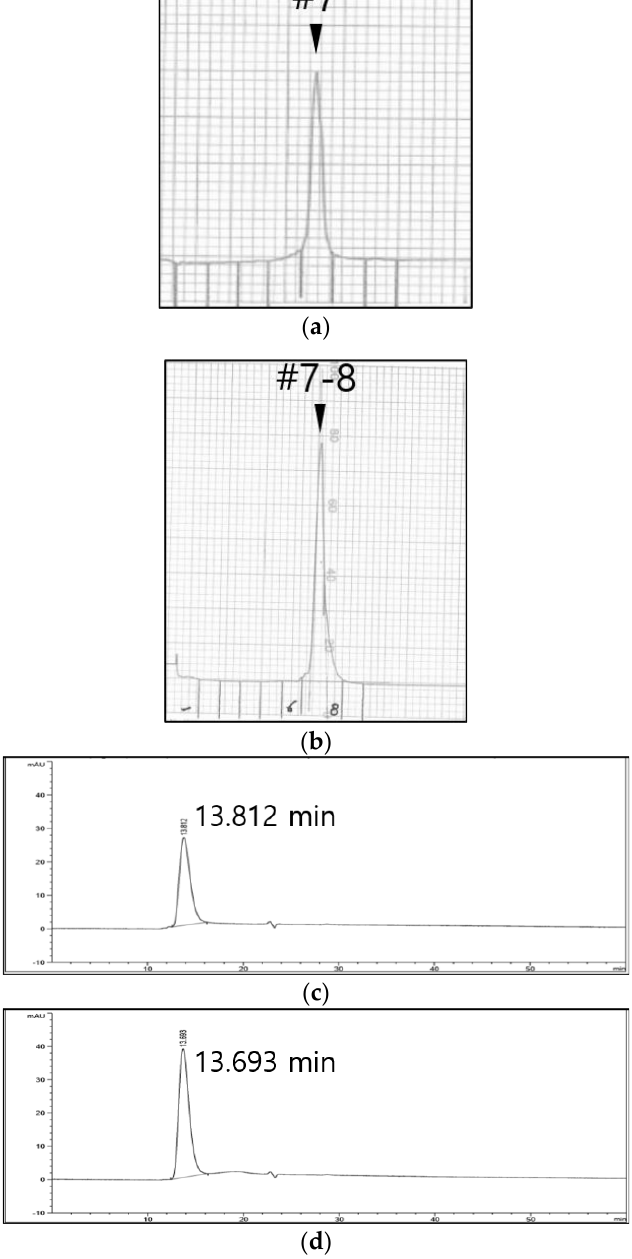
Figure 4. Physical characteristics of BEV as an FMDV surrogate for quantification. ( a ) An original chromatogram from SDG fractionation of SDG-purified FMDV O BE vaccine antigen. Numbers above the target peak indicate the main fraction number. ( b ) An original chromatogram from SDG fractionation of SDG-purified BEV antigen. Numbers above the target peak indicate the main fraction number. ( c ) An original chromatogram from SE-HPLC fractionation of SDG-purified FMDV O BE vaccine antigen. Detection time of the target peak was noted. ( d ) An original chromatogram from SE-HPLC fractionation of SDG-purified BEV antigen. Detection time of the target peak was noted. Abbreviations: BEV, bovine enterovirus; SDG, sucrose density gradient ultracentrifugation; SE-HPLC, size-exclusion high-performance liquid chromatography.